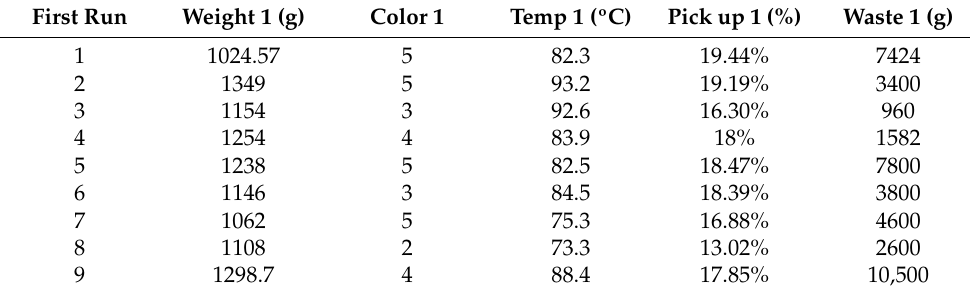
Table 4. Responses for the first run, based on Taguchi L9.